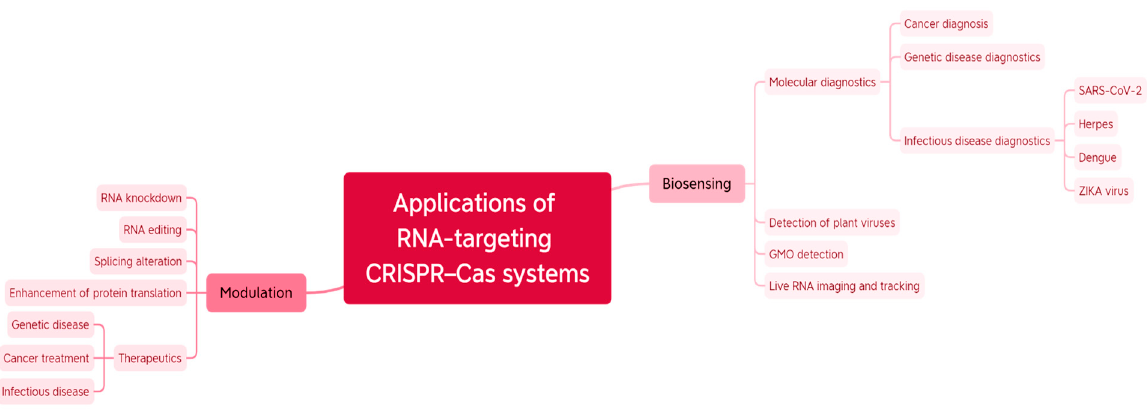
Figure 2. RNA-targeting CRISPR systems applications.